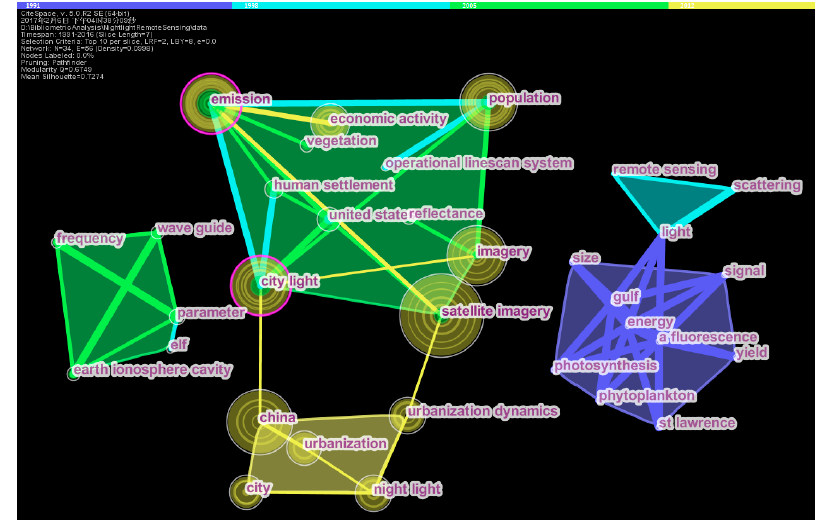
Figure 12. Visualization of a co-word network in the NTL field.